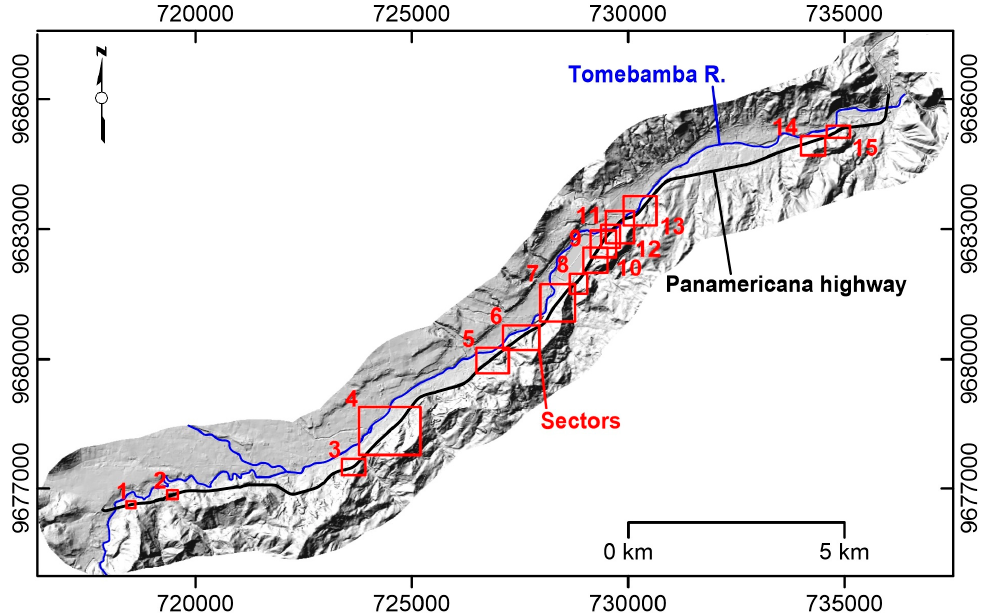
Figure 5. Red polygons correspond to sectors identified through geomorphological analysis and then used to perform QPROTO investigation. On 15 identified sectors, 12 correspond to road cuts.